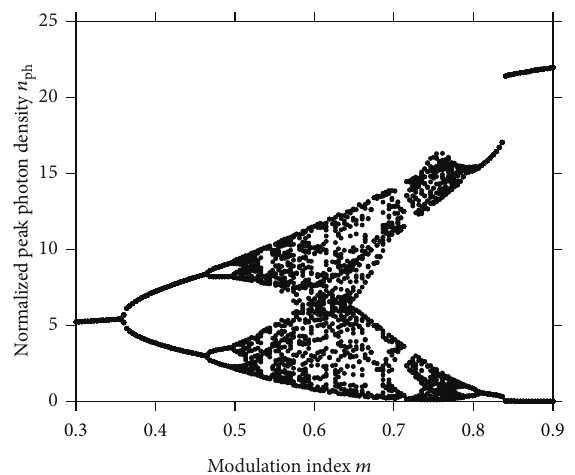
Figure 1: Bifurcation diagram: photon density dependence of modulation